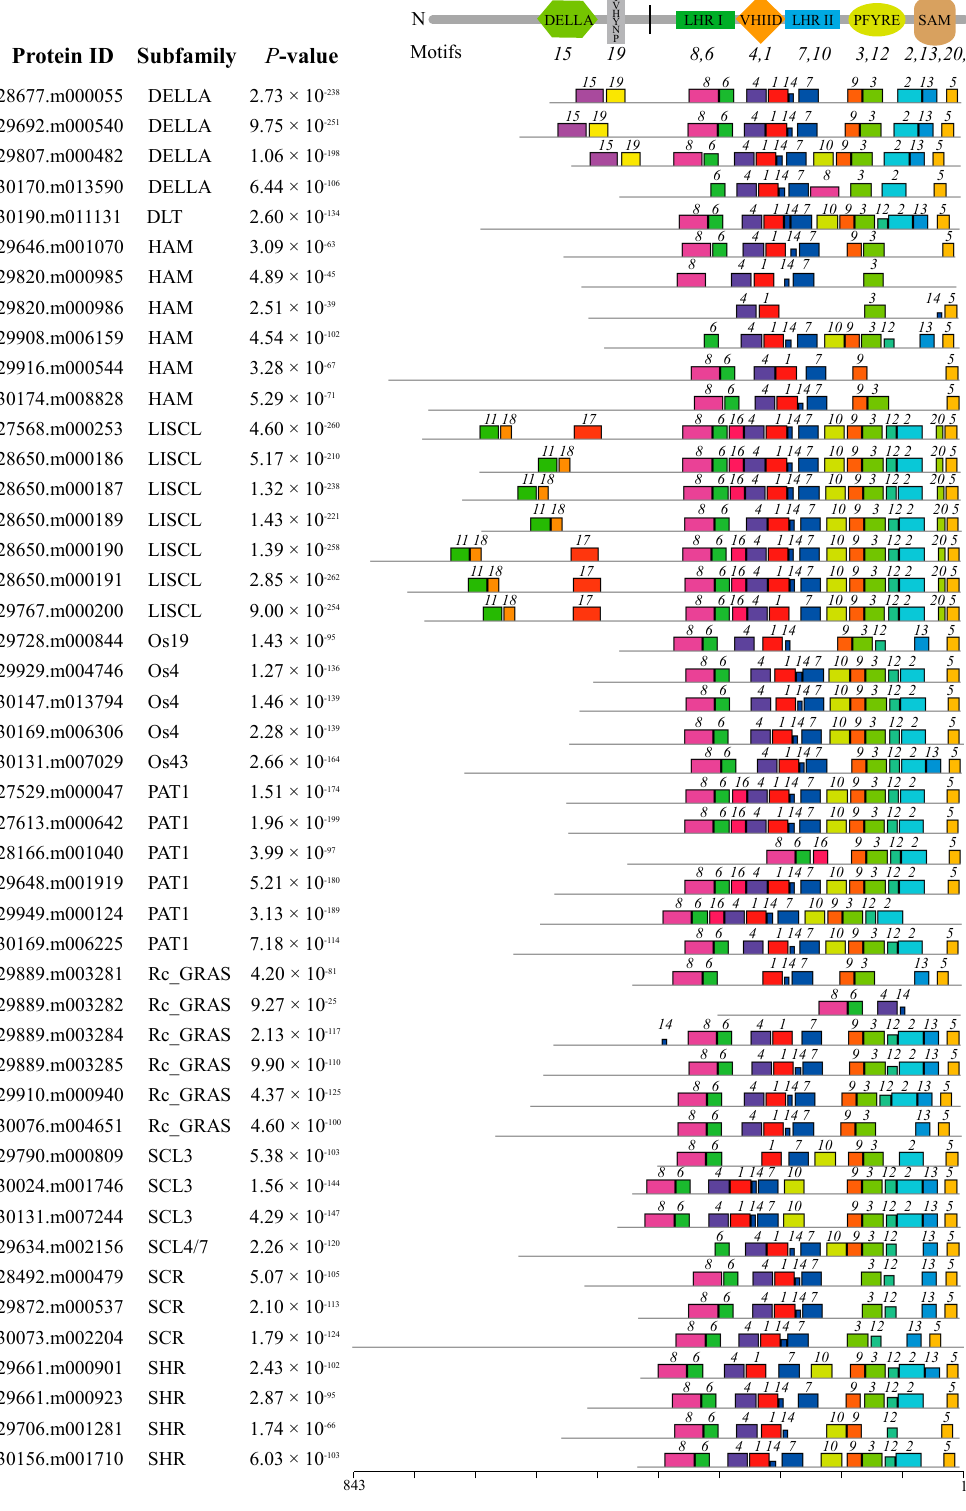
Figure 2. The distribution of conserved motifs within GRAS proteins in castor beans. The different colors indicate the conserved motifs within each protein. The conserved domains within the GRAS protein sequences and corresponding motifs are shown at the top. The scale for protein length is shown at the bottom.